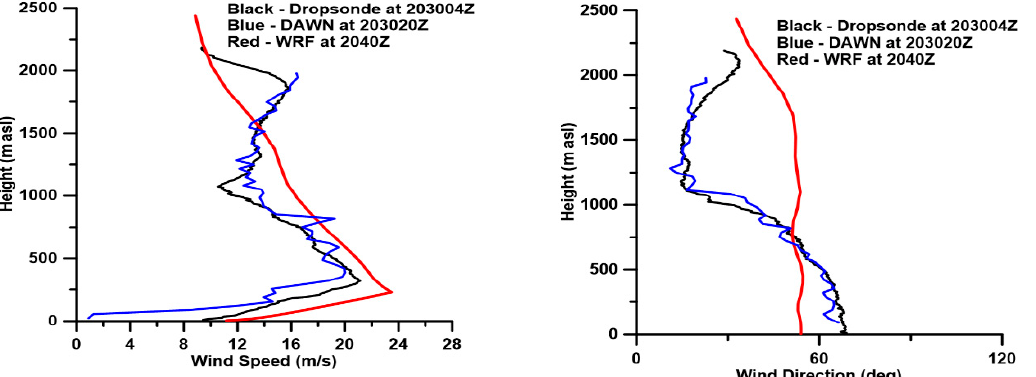
Figure 8. DAWN, dropsonde and model profiles of wind speed ( left ) and wind direction ( right ) closer to the coast around 2030Z on 21 May 2015.